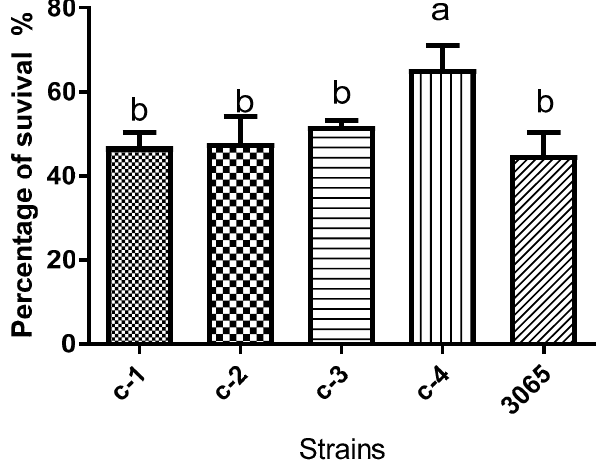
Figure 3. Aciduricity (acid tolerance). Percentage (%) of bacterial survival obtained after exposition to glycine buffer in pH 3.5 for 60 min: 3065: S. mutans KCTC 3065 C-1: Streptococcus salivarius ; C-2: Streptococcus anginosus ; C-3: Leuconostoc mesenteroides ; C-4: Lactobacillus sakei . Vertical bars represent standard error of the mean ( n = 3), different letters in the same group indicate a significant ( p < 0.05) treatment effect.